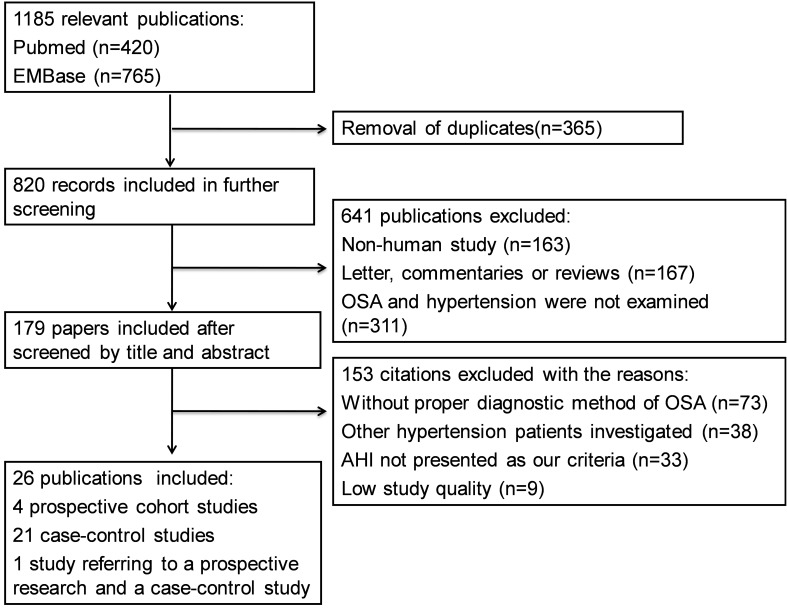
Flowchart of the study selection.